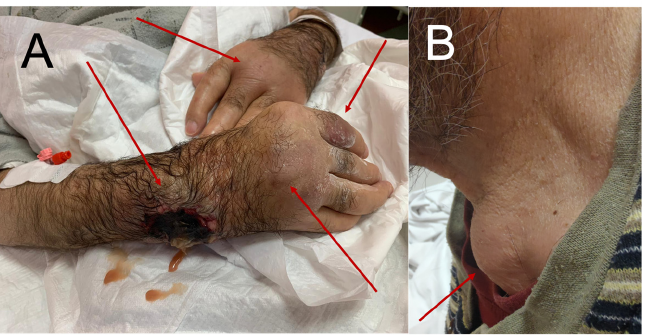
Figure 1. Abscesses in the subcutaneous tissue: ( A ) in the area of the hands, necrosis present in the area of the right wrist after the spontaneous rupture of an abscess; ( B ) abscess in the left supraclavicular fossa.